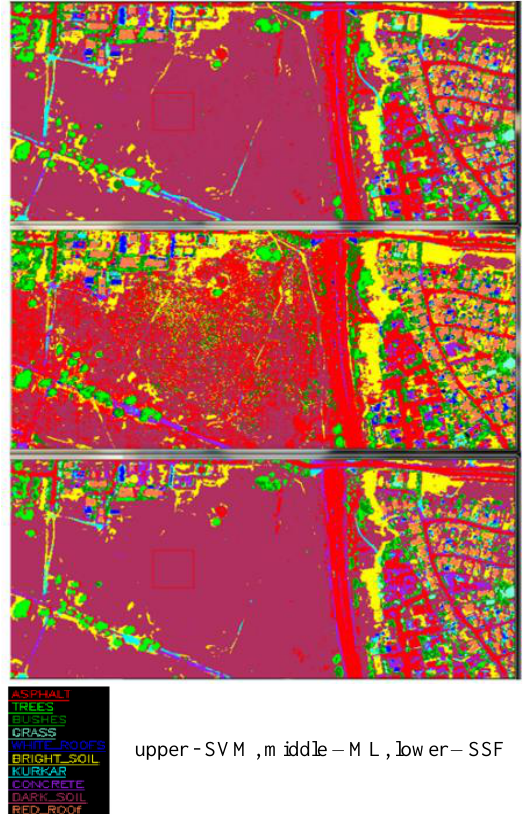
Figure 6. classification results